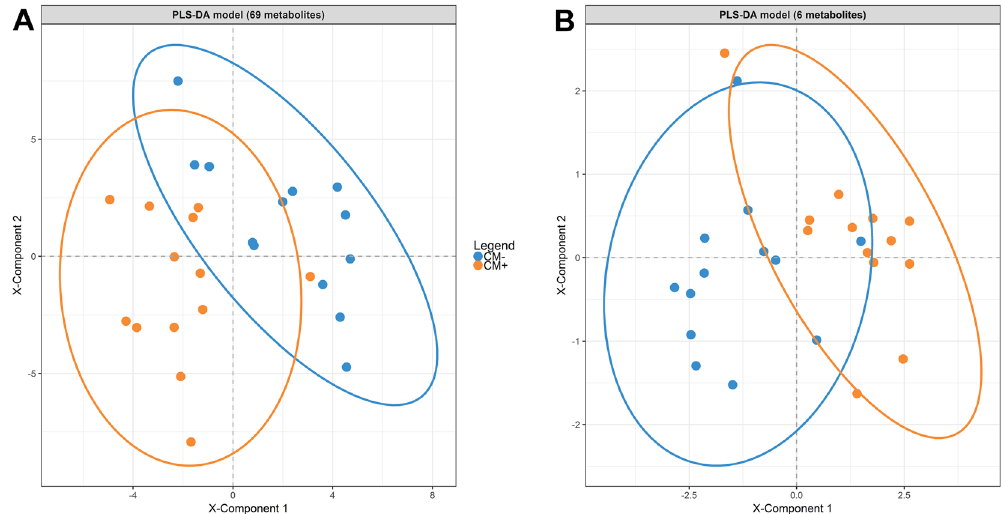
Figure 1. ( A and B ) Separation of women with (orange, N = 13) and without (blue, N = 13) childhood maltreatment (CM) experiences in the validation set based on the in cross-validation selected 3-component PLS-DA model with 69 metabolites (VIP threshold = 1.2, accuracy: 80.8%, sensitivity: 76.9%, specificity: 84.6%; A ) or a more economical 3-component PLS-DA model with only six metabolites (VIP threshold = 2.5, accuracy: 88.5%, sensitivity: 92.3%, specificity: 84.6%; B ).